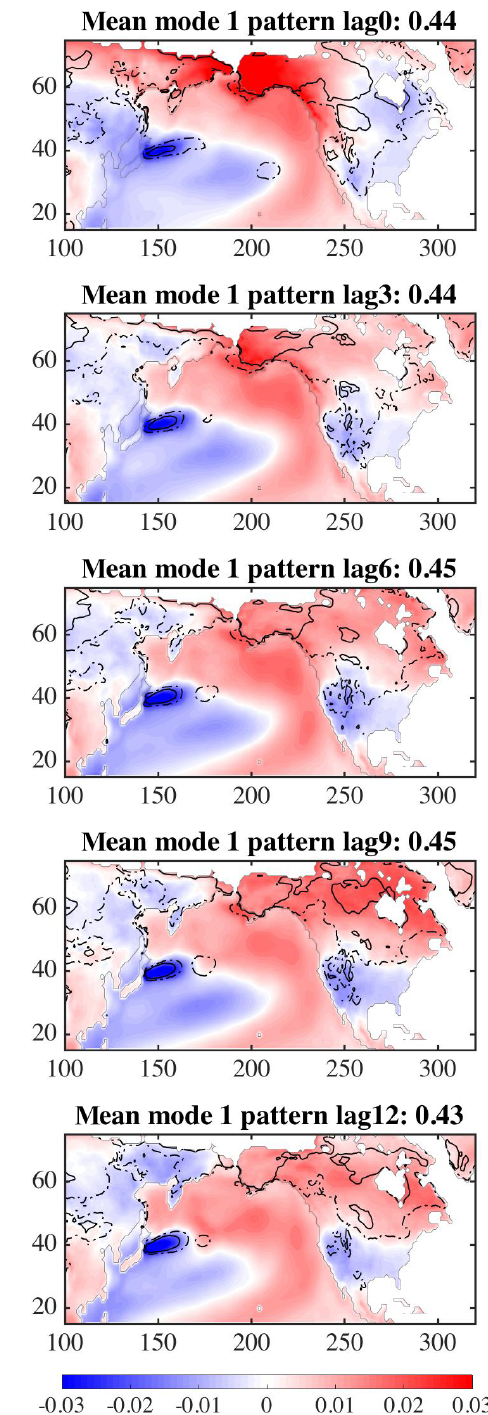
Figure 8. The mean MCA pattern over 30 models, at lags 0, 3, 6, 9 and 12 months. Contours represent relative variance for 30 simula- tions as in Fig. 6. Contours are for 0.0004 and 0.0008. The number in the title represents the percent